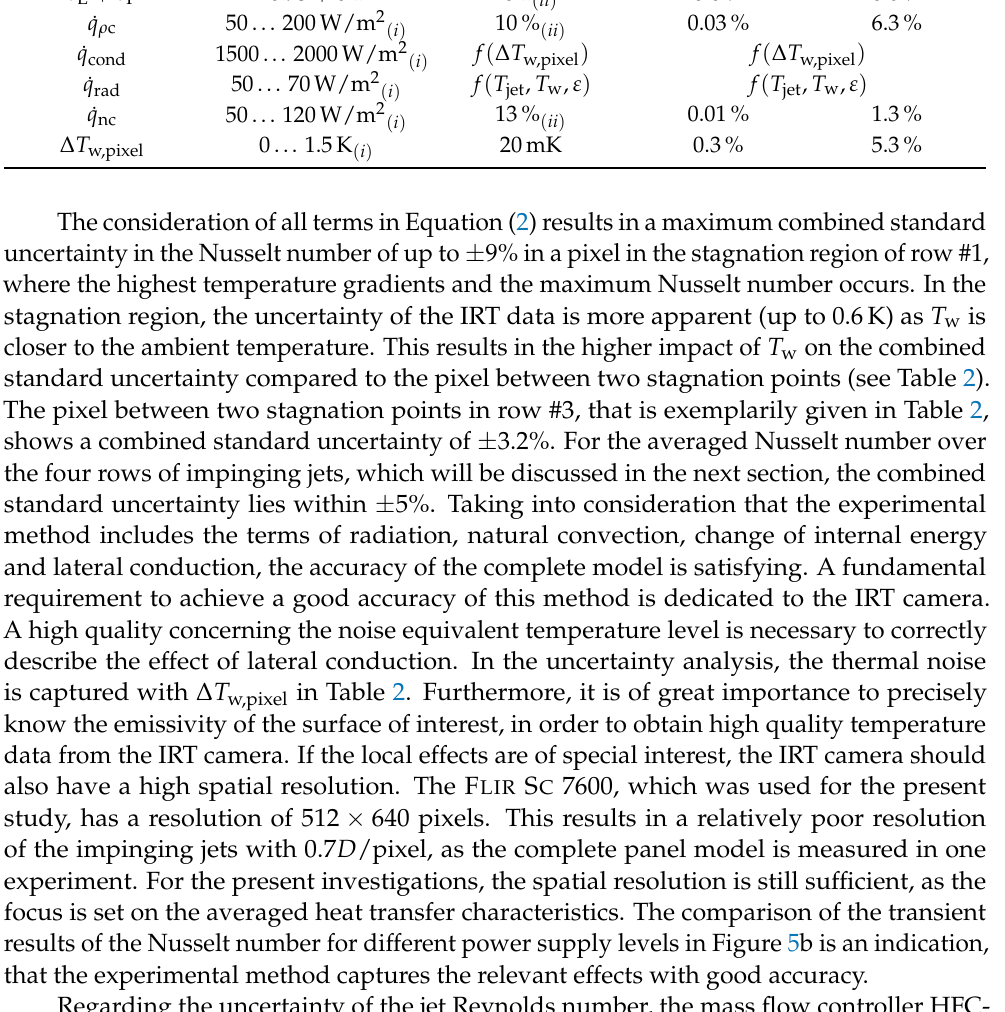
Table 2. Measurement uncertainties of contributing factors on the estimation of the local Nusselt number; ( i ) Stagnation region, ( ii ) Assumption. Contrib. Factor Value of Interest Uncertainty T jet 292 . . . 298K 0.2K 9.3% 8.4% T w 301 . . . 343K 0.6 . . .